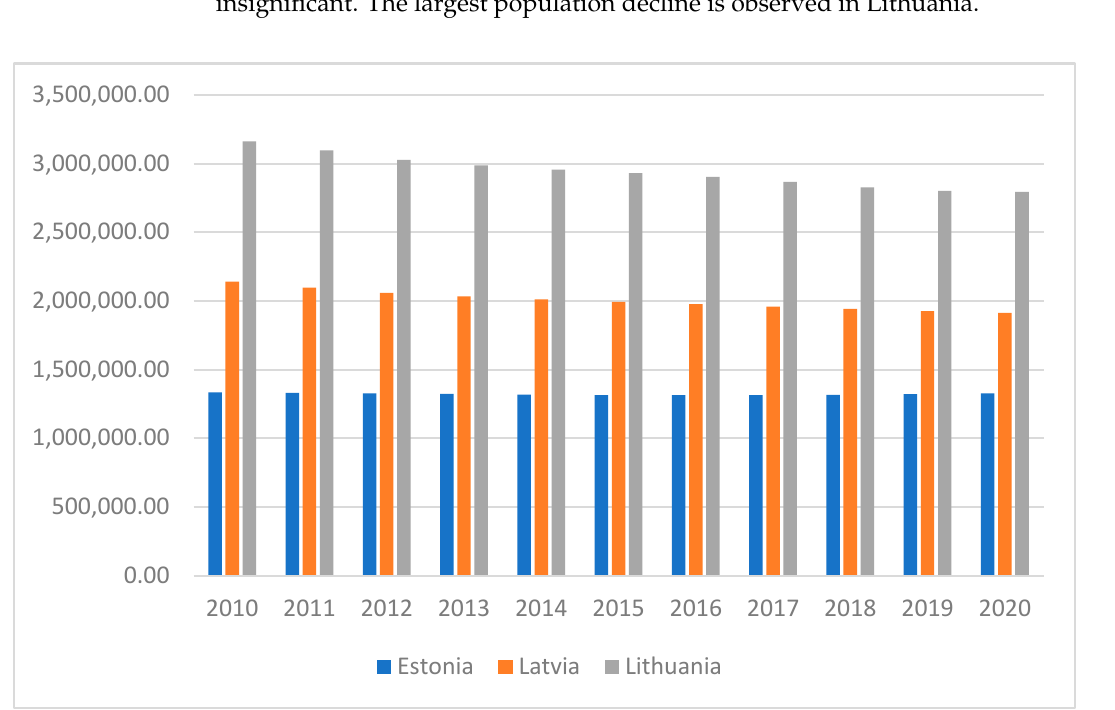
Figure 1. Population dynamics in the Baltic states over the period of 2010–2020.